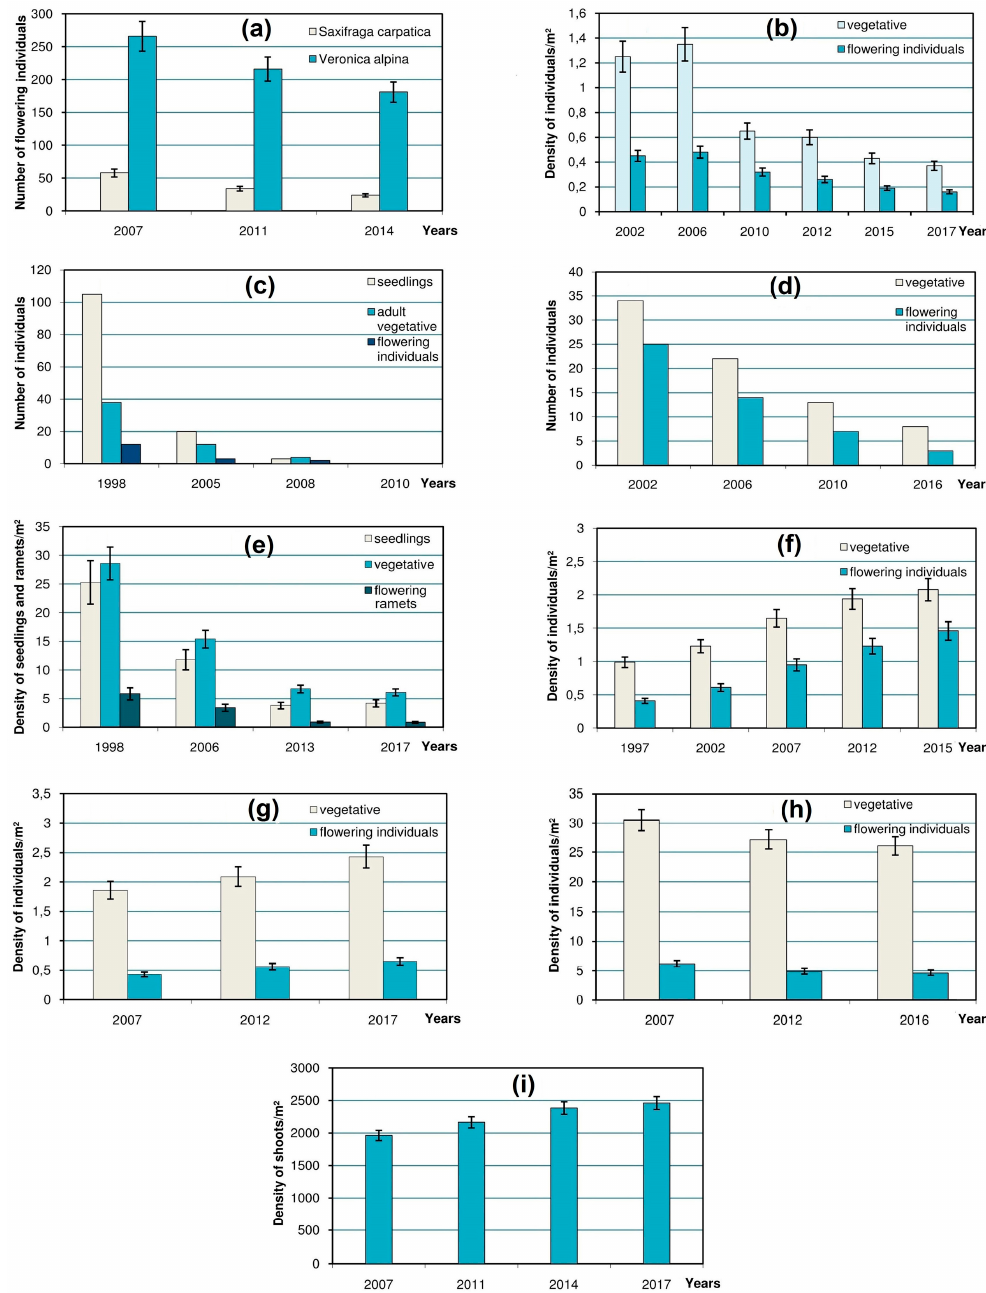
Figure 3. Dynamics of population size of the studied alpine rare species in different types of habitats in the Ukrainian Carpathians: ( a ) Saxifraga carpatica and Veronica alpina in their snowbed habitat (census of flowering individuals); ( b ) Cardaminopsis neglecta in its scree habitat (density of vegetative and flowering individuals); ( c ) Erigeron atticus in its rocky habitat (census of seedlings, vegetative, and flowering individuals); ( d ) Veronica bellidioides in its ridge habitat (census of vegetative and flowering individuals); ( e ) Swertia perennis subsp. alpestris in its mire habitat (density of seedlings, vegetative, and flowering ramets); ( f ) Achillea lingulata in its tall-herb habitat in the Chornohora Mts (density of vegetative and flowering individuals); ( g ) Senecio carpathicus in its sward habitat (density of vegetative and flowering individuals); ( h ) Polygonum viviparum in its sward habitat in the Chornohora Mts (density of vegetative and flowering individuals); ( i ) Loiseleuria procumbens in its dwarf-shrub heath habitat (density of shoots). Location and size of plots are described in Table 1. Error bars are 90% confidence intervals for a corresponding sample size.